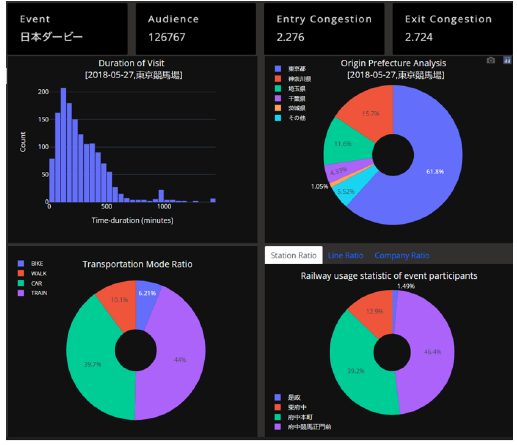
Figure 7. Event-statistics